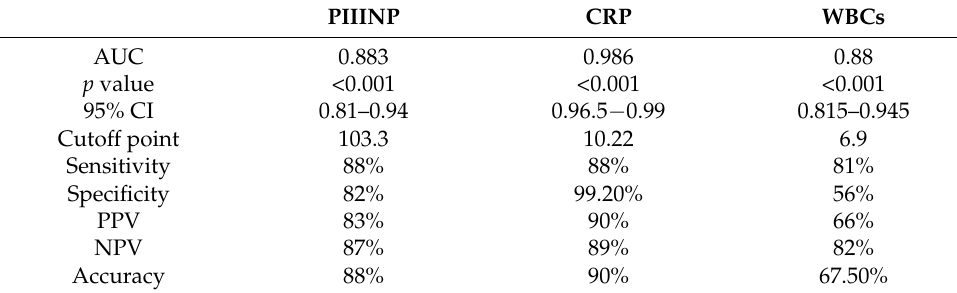
Table 5. Validity of PIIINP, CRP, and WBCs for prediction of sepsis.